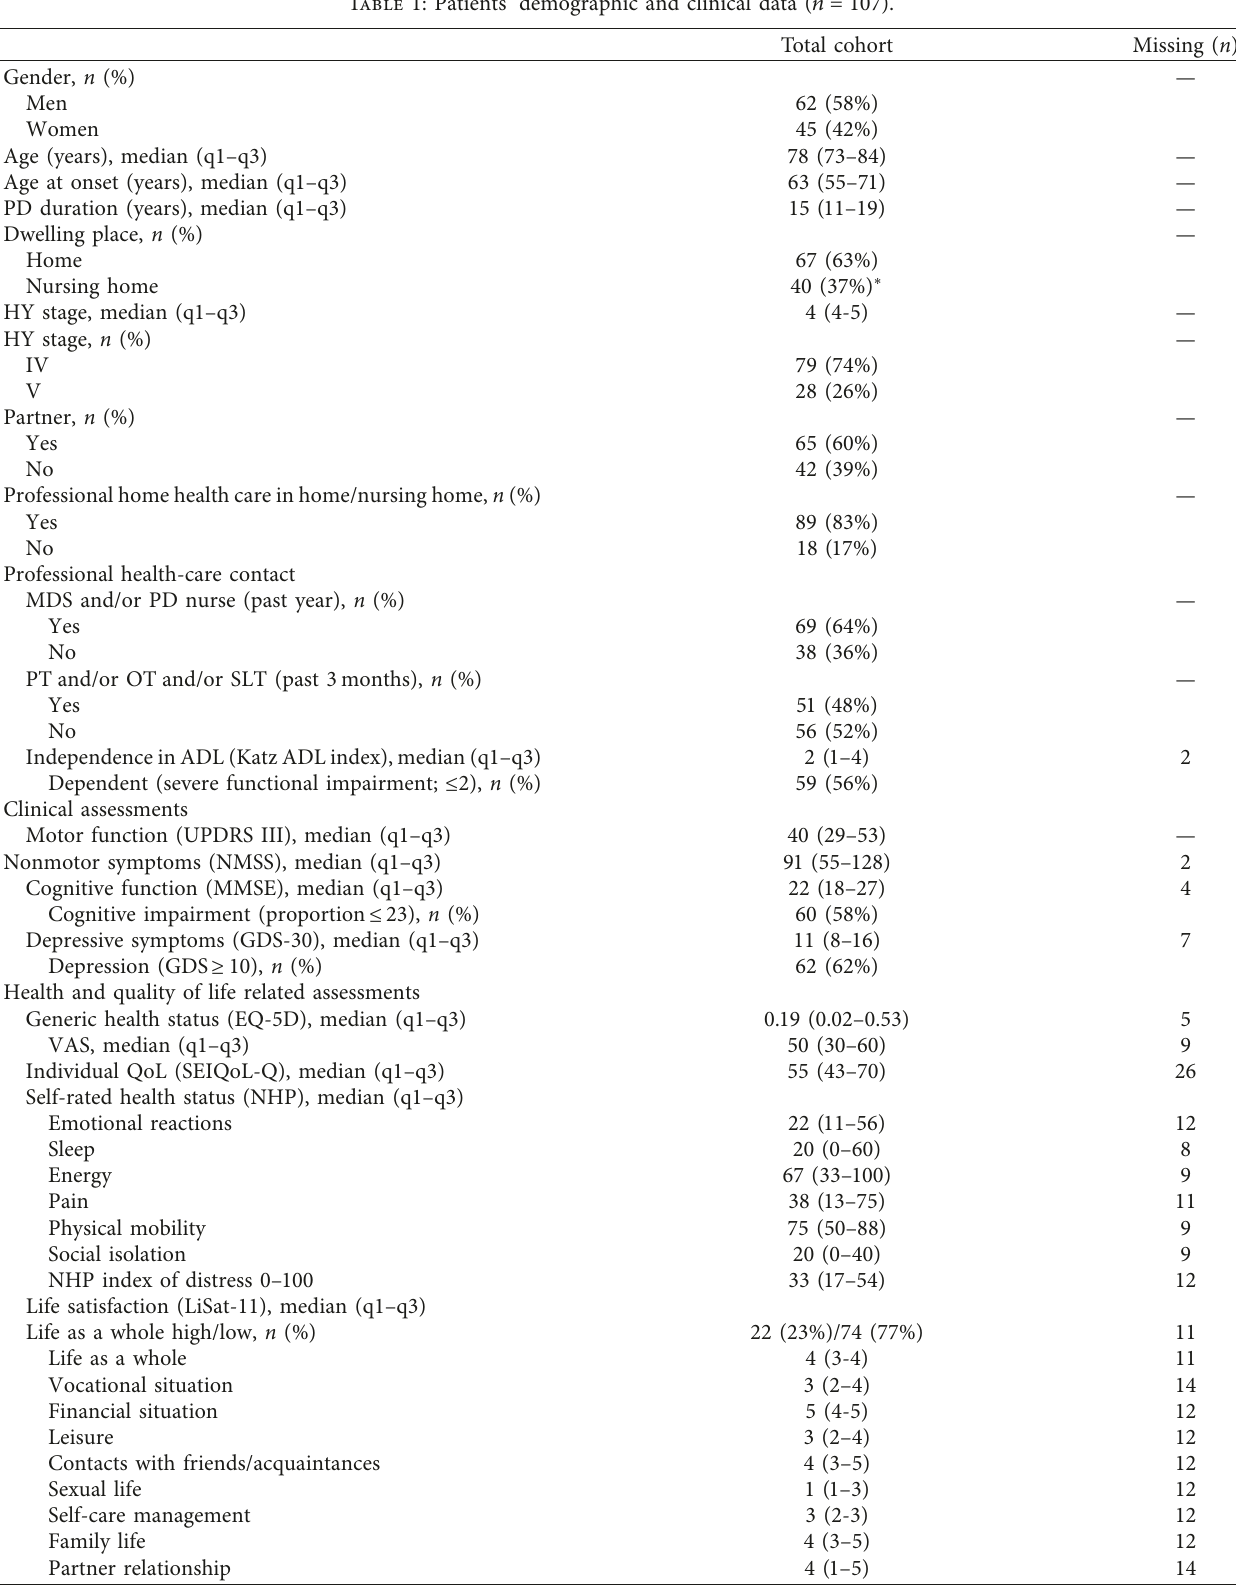
Table 1: Patients’ demographic and clinical data ( n �